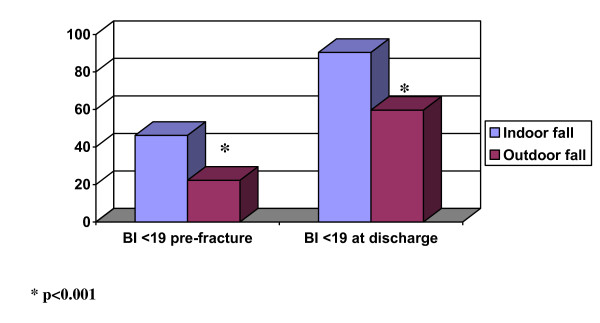
Proportion of patients (%) with ADL function (Barthel Index) < 19 pre-fracture and at discharge from hospital according to indoor or outdoor fall.